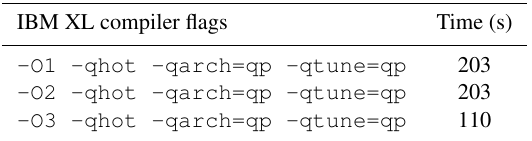
Table 2. Weak scaling efficiency, load balance efficiency, commu- nication efficiency, and parallel efficiency, running the weak scaling experiment up to 32768MPI